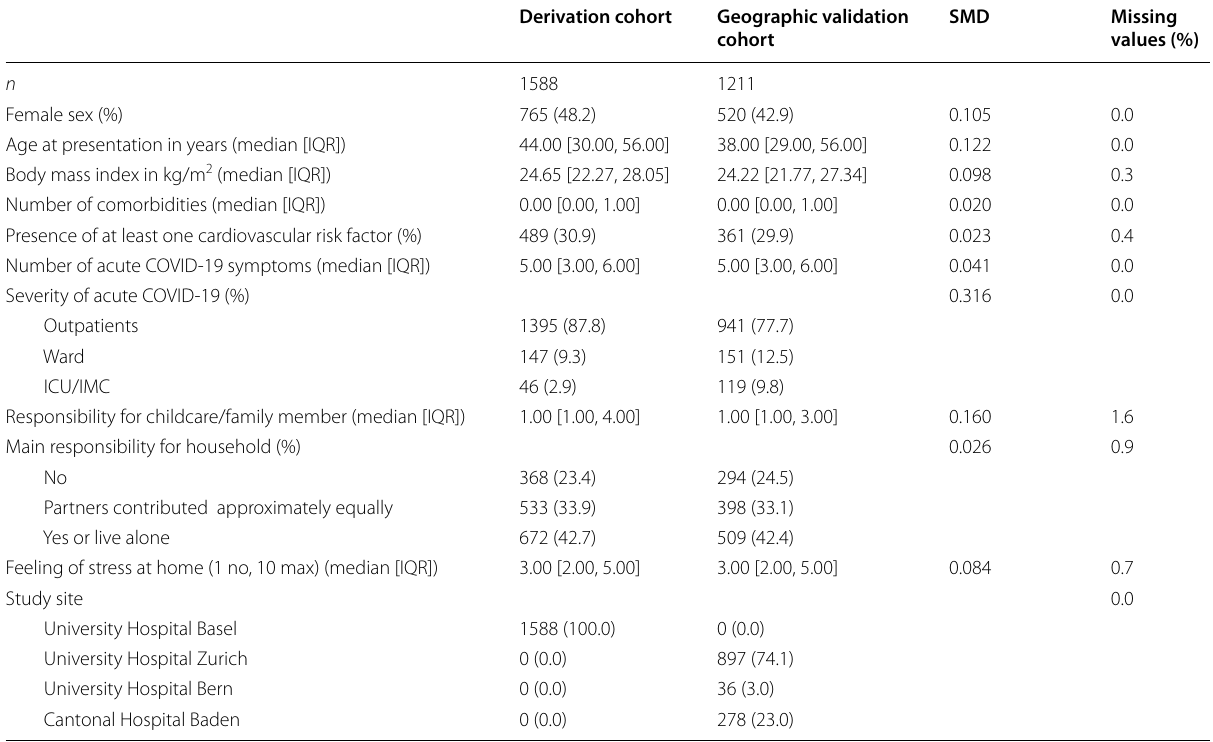
Table 1 Study participants characteristics, stratified by data